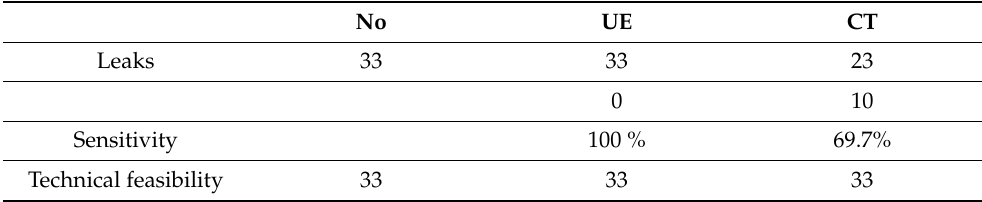
Table 2. Efficiency and Feasibility of UE and